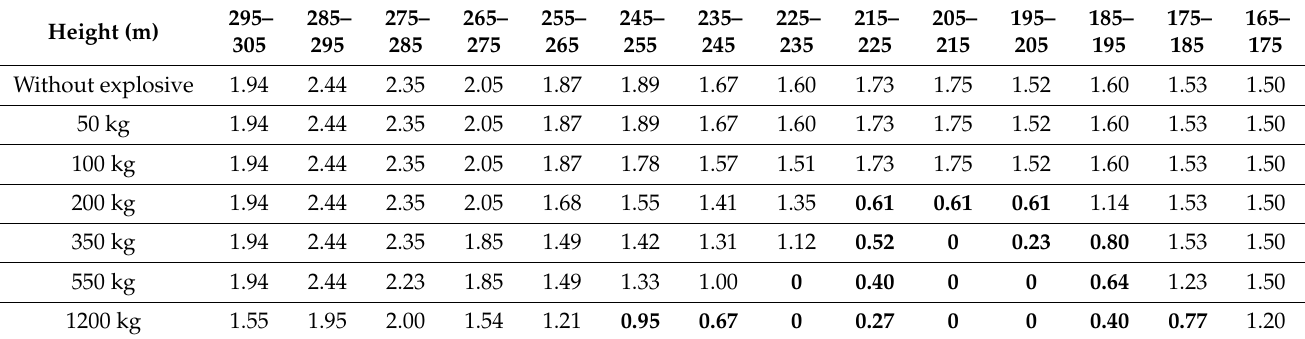
Table 7. Effect of underwater contact explosion on antisliding stability safety factor of each